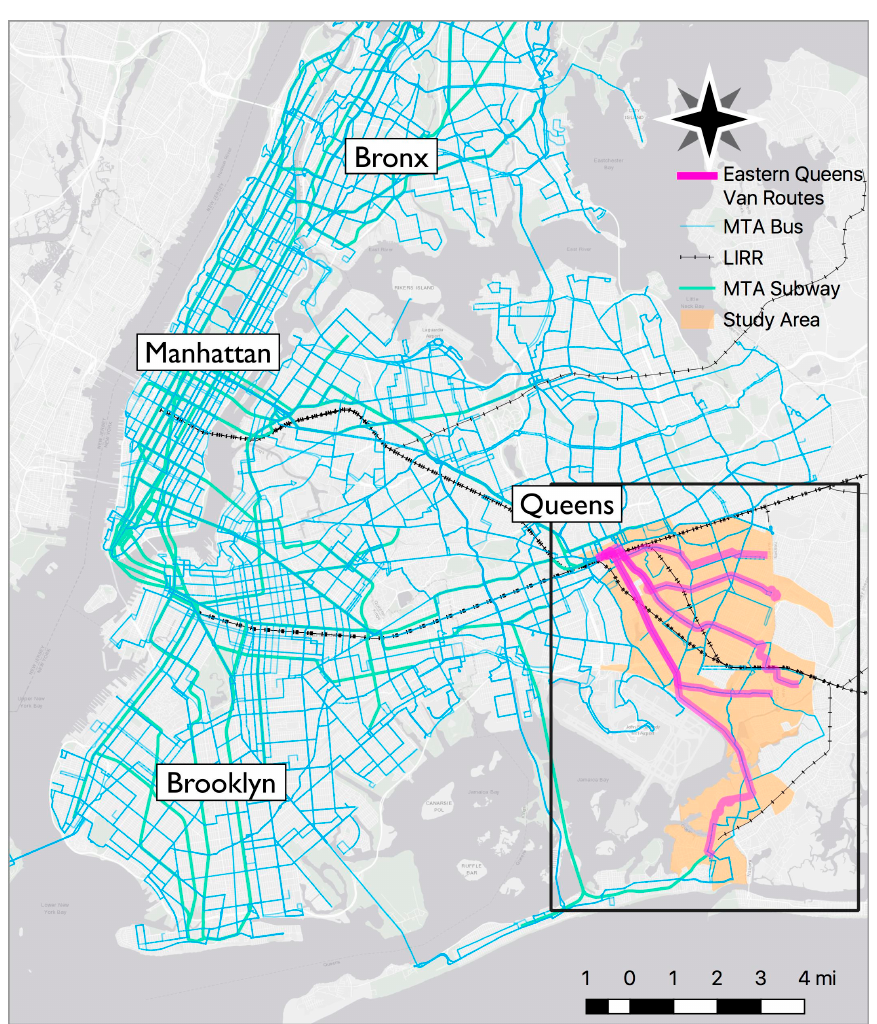
Figure 1. The study area, Metropolitan Transportation Authority (MTA), and commuter van routes.